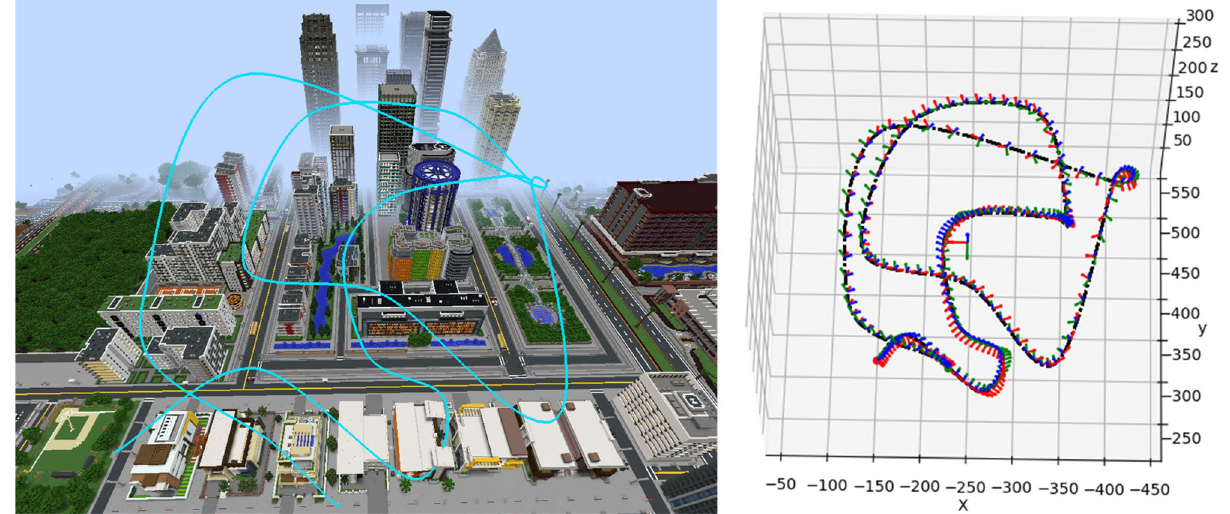
Figure 4. The accurate camera 6 DoF pose at any timestamp in the path is gotten by exporting the key points of the Aperture path and